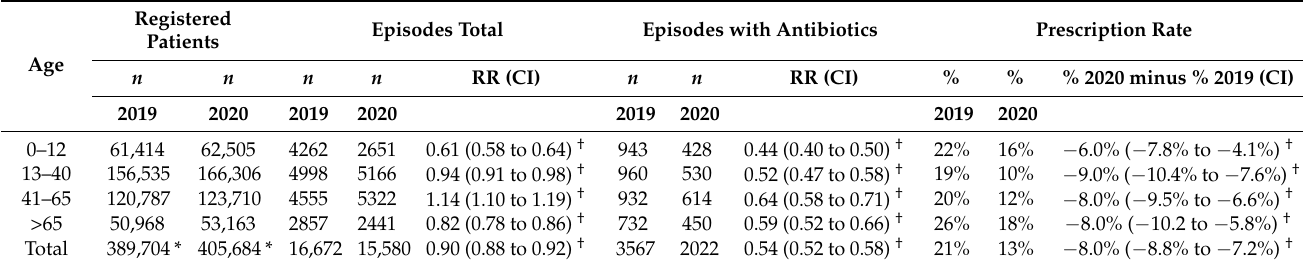
Table 2. Number of disease episodes and episodes with antibiotic prescription for respiratory tract and ear infection episodes per age category in 2019 and 2020 (March through May). Registered Episodes Total Episodes with Antibiotics Prescription Patients Age